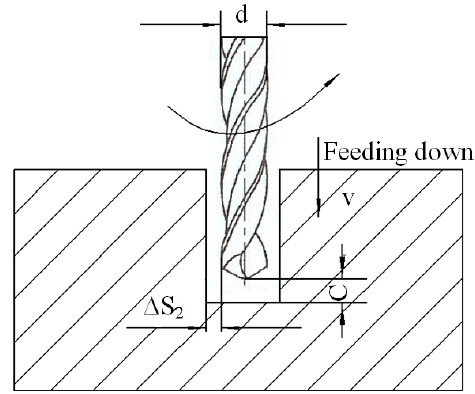
Figure 3. A schematic view of electrochemical discharge drilling.